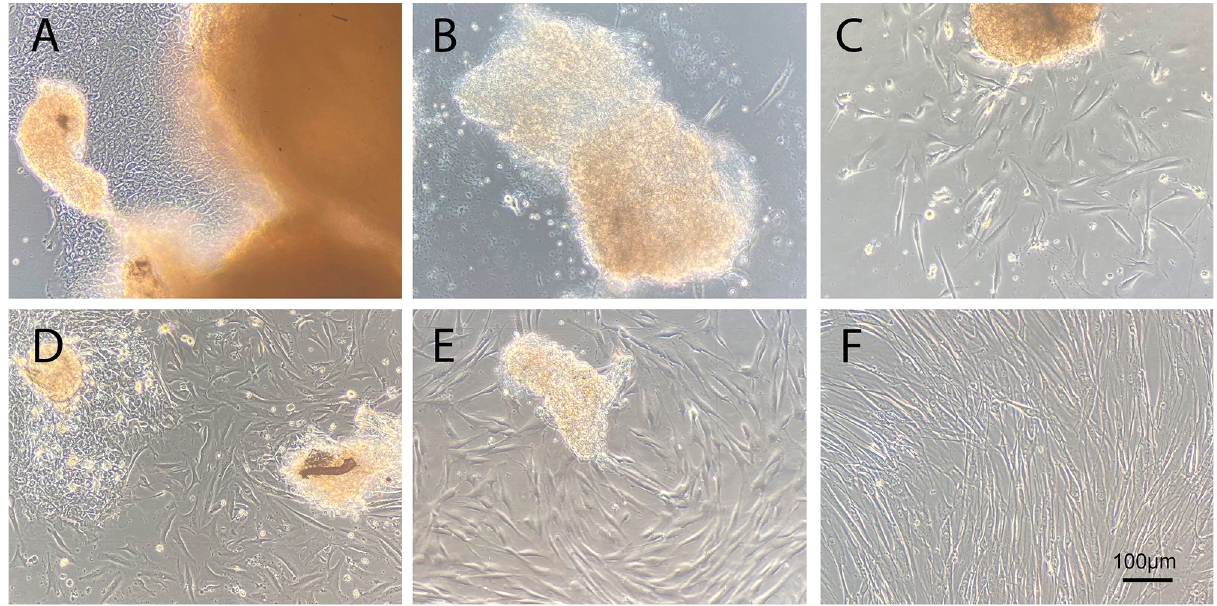
Figure 2- Isolation and culture of human gingival fibroblasts (HGFs).(A) The appearance of primary HGFs cultured for two days.(B) The appearance of primary HGFs cultured for four days.(C) The appearance of primary HGFs cultured for seven days.(D) The appearance of primary HGFs cultured for10 days.(E) After 14 days of culture, the primary HGFs reached 80-90% confluency.(F) The appearance of HGFs after passaging. Scale bar =